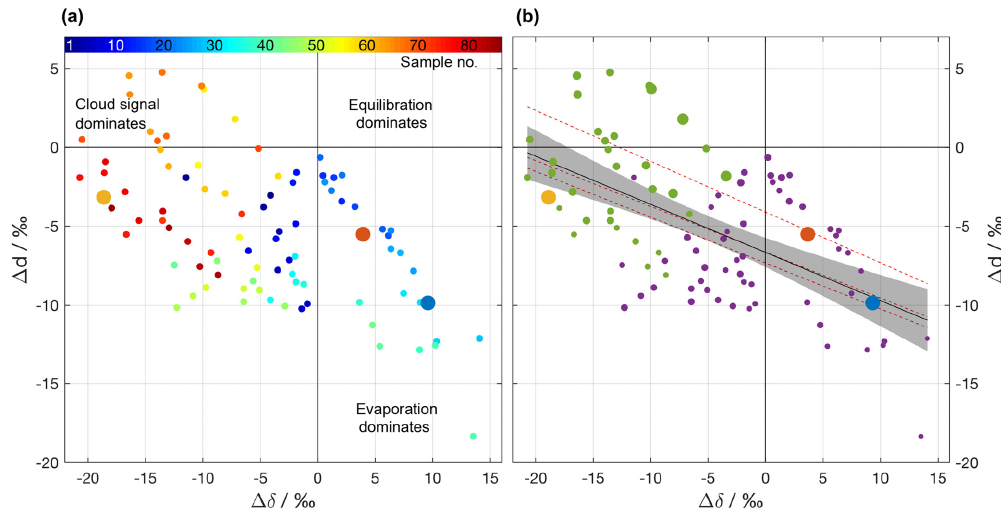
Figure 6. (cid:49)δ(cid:49)d -diagram for the precipitation samples collected on 20 November 2015. (a) Samples coloured according to their sequential sample number (see legend) to highlight the temporal evolution of (cid:49)δ and (cid:49)d . (b) Same samples as in (a) , but with pre-frontal samples coloured in purple and post-frontal ones in green. The size of the circle corresponds to the average rain intensity of the sample. The solid black line represents a linear fit through all samples with the 95% confidence band in shading. Dashed red lines correspond to the linear fits through the samples of three other events (cf. text). Data points from reference simulations shown as large yellow, red, and blue dots.